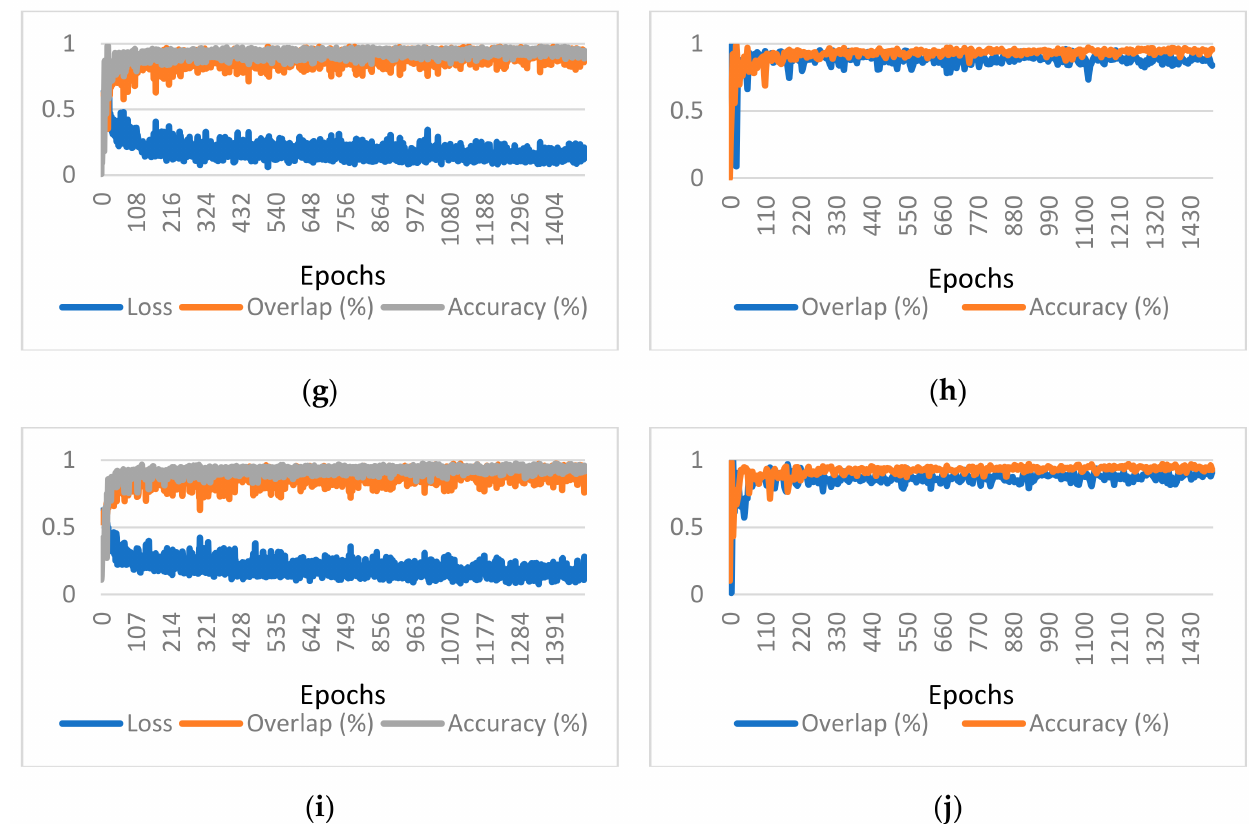
Figure A1. Graphs of the evaluation metrics for different parameter configurations for training and validation, respectively, ( a , b ) 128 × 128 × 96, batch size 1, reduction 1, only patches with ground truth; ( c , d ) 128 × 128 × 128, batch size 2, reduction 2, only patches with ground truth; ( e , f ) 256 × 256 × 128, batch size 1, reduction 2; ( g , h ) 320 × 320 × 64, batch size 1, reduction 4; and ( i , j ) 384 × 384 × 48, batch size 1, reduction